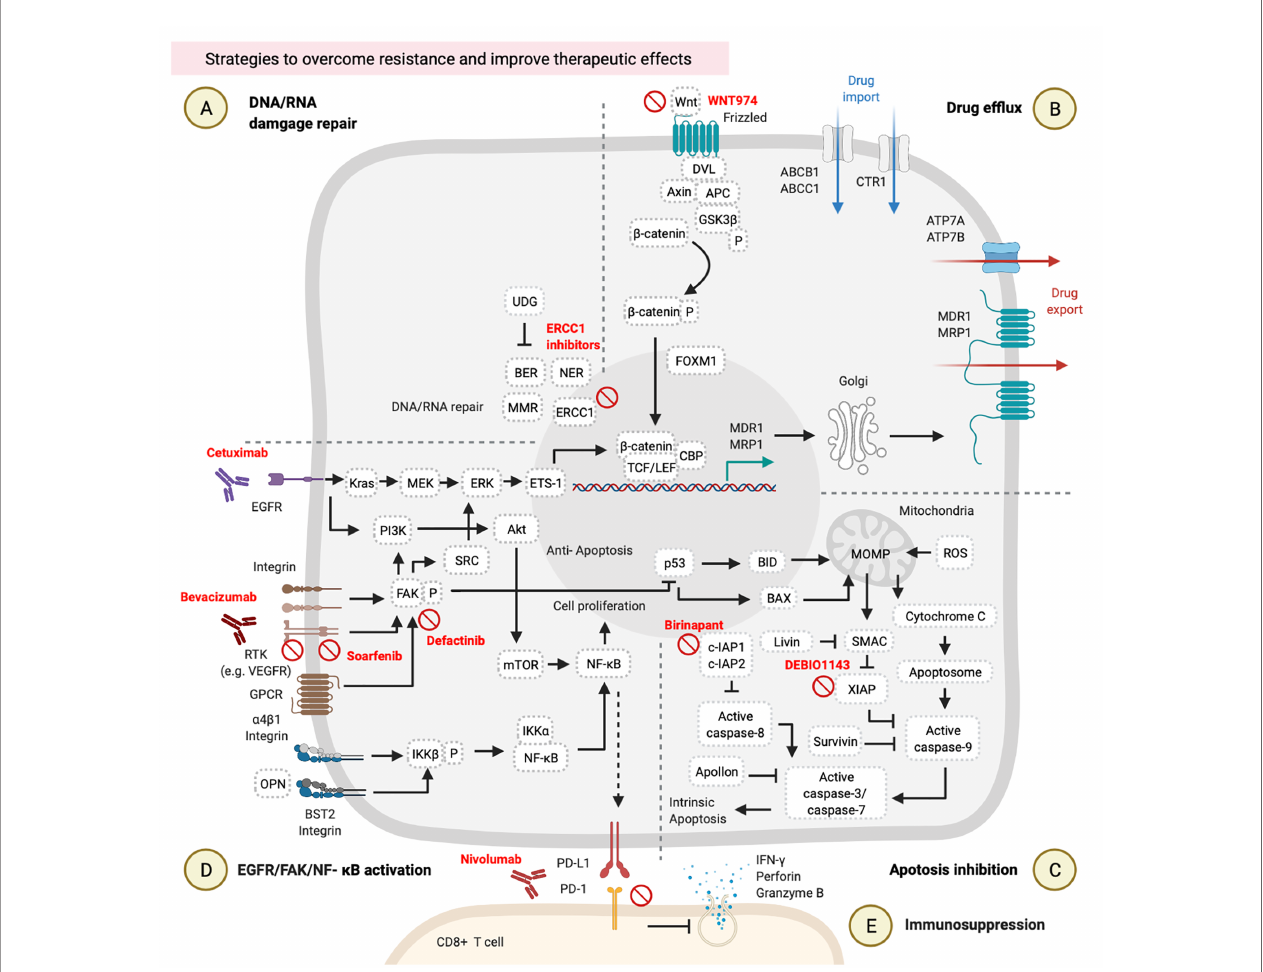
FIGURE 3 | Strategies to overcome resistance and improve therapeutic effects. These involve (A) DNA/RNA damage, (B) drug ef fl ux, (C) apoptosis inhibition, (D) epidermal growth factor receptor (EGFR)/focal adhesion kinase (FAK)/nuclear factor (NF)- k B activation, and (E) immunosuppression. These fi gures were created with